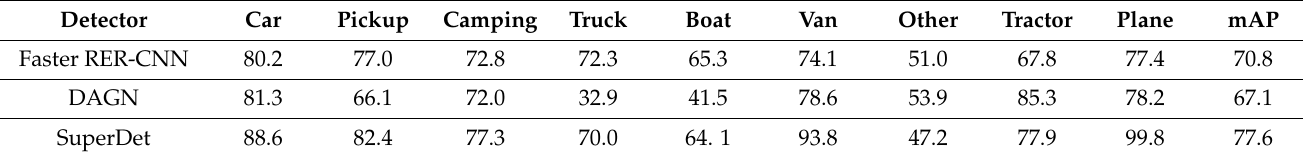
Table 4. Performance comparisons for each class on the VEDAI dataset: AP